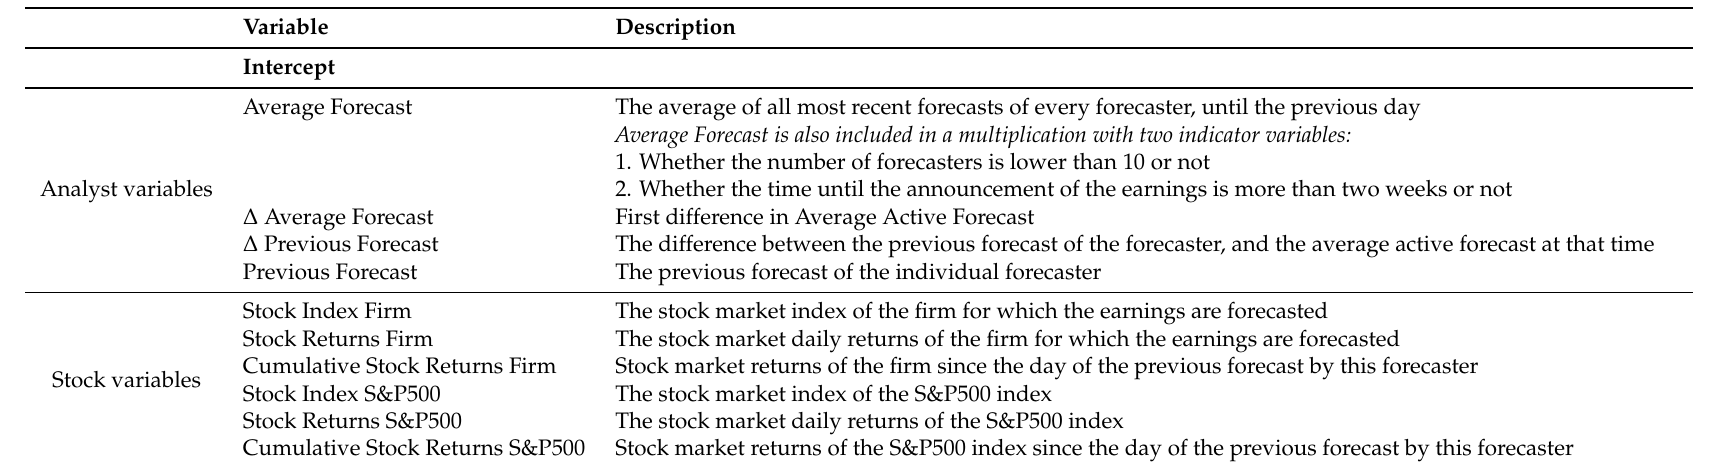
Table 2. The variables that were used to forecast the earnings forecast. These variables enter a linear model. They all use one-day lagged information. Several variables are based on historic analyst behaviour, while others are based on stock market